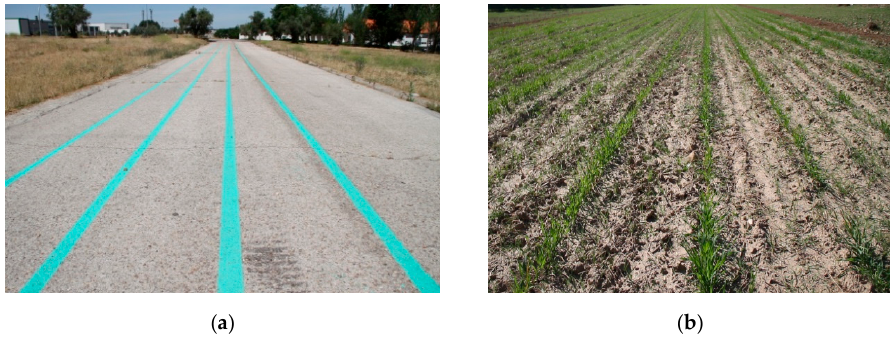
Figure 16. ( a ) First test environment. ( b ) Crop employed in the experiments.